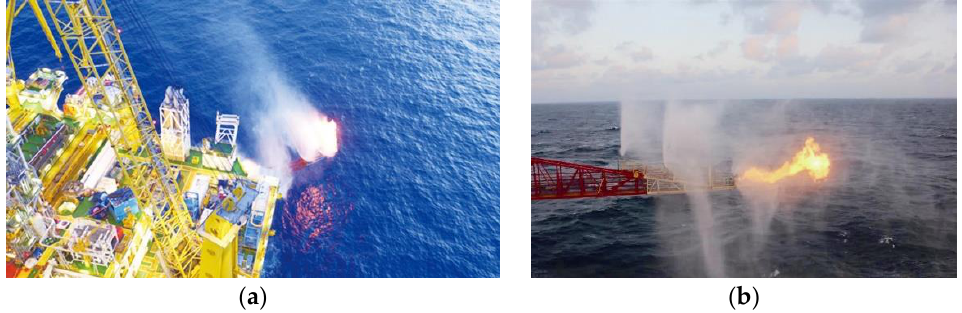
Figure 2. Trial production of natural gas hydrate in China. ( a ) The first round of natural gas hydrate trial production in 2017; ( b ) The second round of natural gas hydrate trial production in 2020.